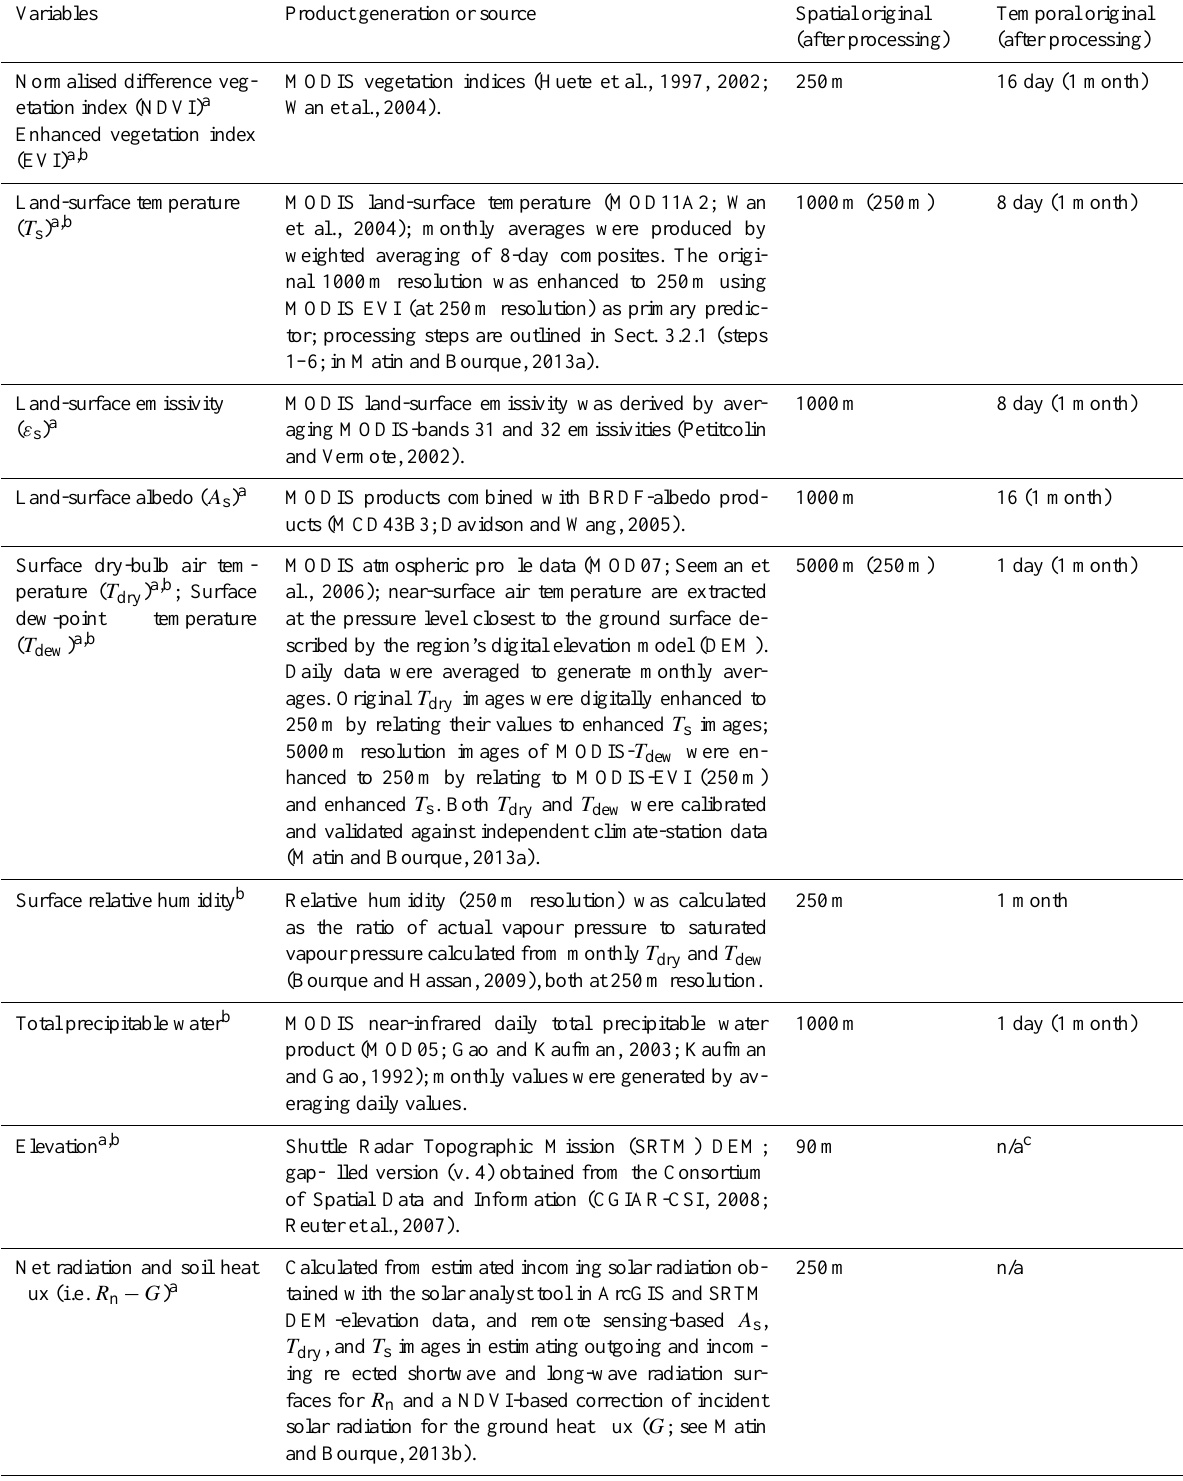
Table 2. Input variables and their image-data sources relevant to the generation of evaporation, precipitation, and snowmelt surfaces addressed in this study, including their spatio-temporal resolutions (columns 3 and 4) before and after spatial enhancement. Bracketed values are not given in cases where spatial enhancement or temporal aggregation were not used (modified after Matin and Bourque,